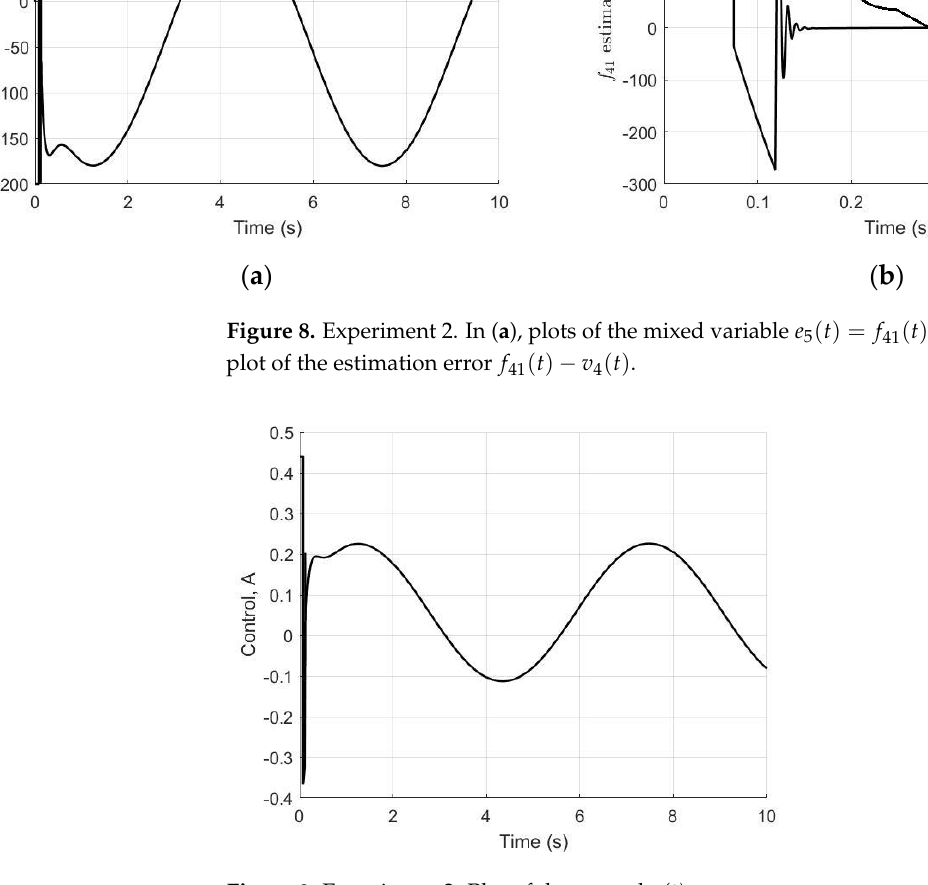
Figure 9. Experiment 2. Plot of the control u(t).